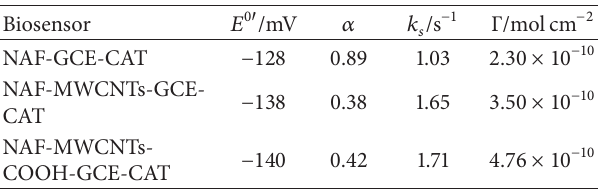
Table 2: Electrochemical parameters for immobilized catalase either in the absence or in the presence of